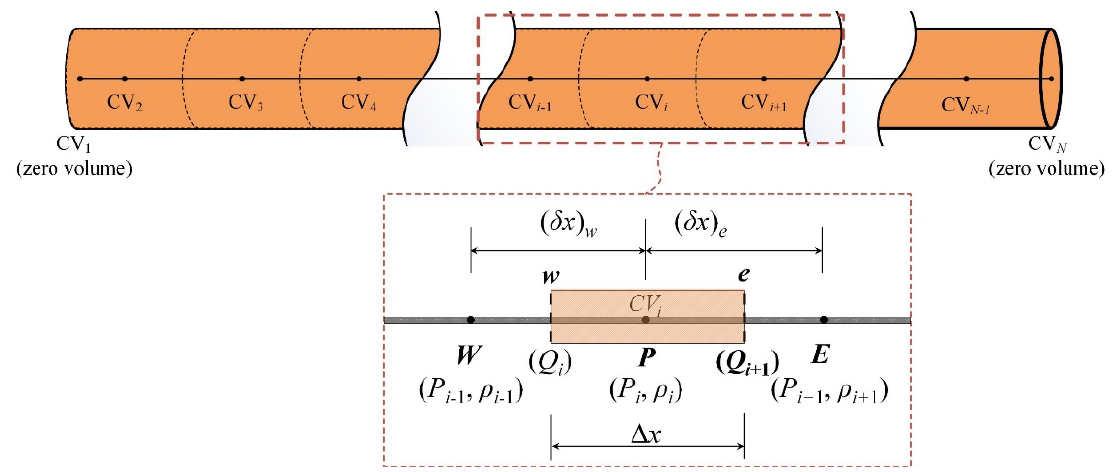
Figure 2. Illustration of the discrete control volumes.